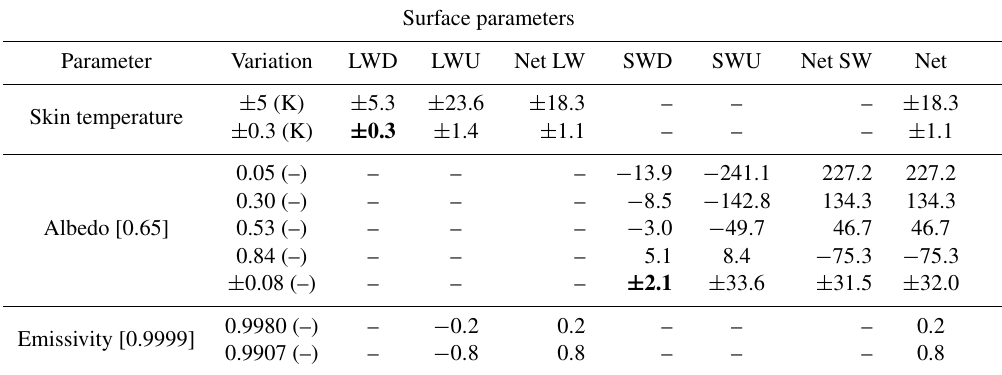
Table A2. Variation of several surface parameters. The table indicates the mean upward (U) and downward (D) SW and LW flux differences at the surface of clear-sky (CS) perturbed simulations minus idealized atmosphere simulation. Values in Wm − 2 . Values highlighted in bold are used as